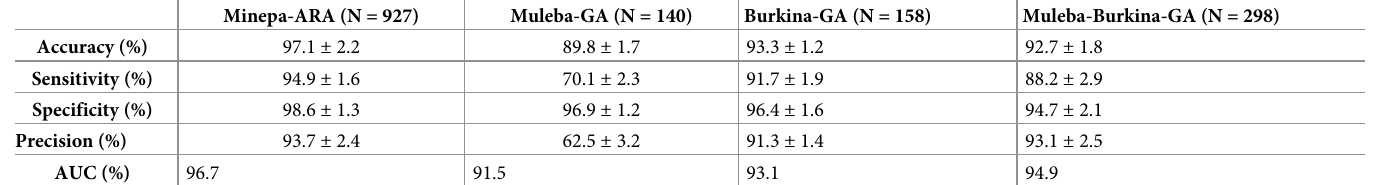
Table 4. Performance of an ANN model trained on 75% of the encoded mosquito spectra (10 features) and tested on the remaining 25% of the encoded mosquito spectra. AUC values are the area of the ROC curves in Fig 10. Minepa-ARA (Nulliparous = 656, Parous = 271), Muleba-GA (Nulliparous = 119, Parous = 21), Burkina- GA (Nulliparous = 80, Parous = 78).